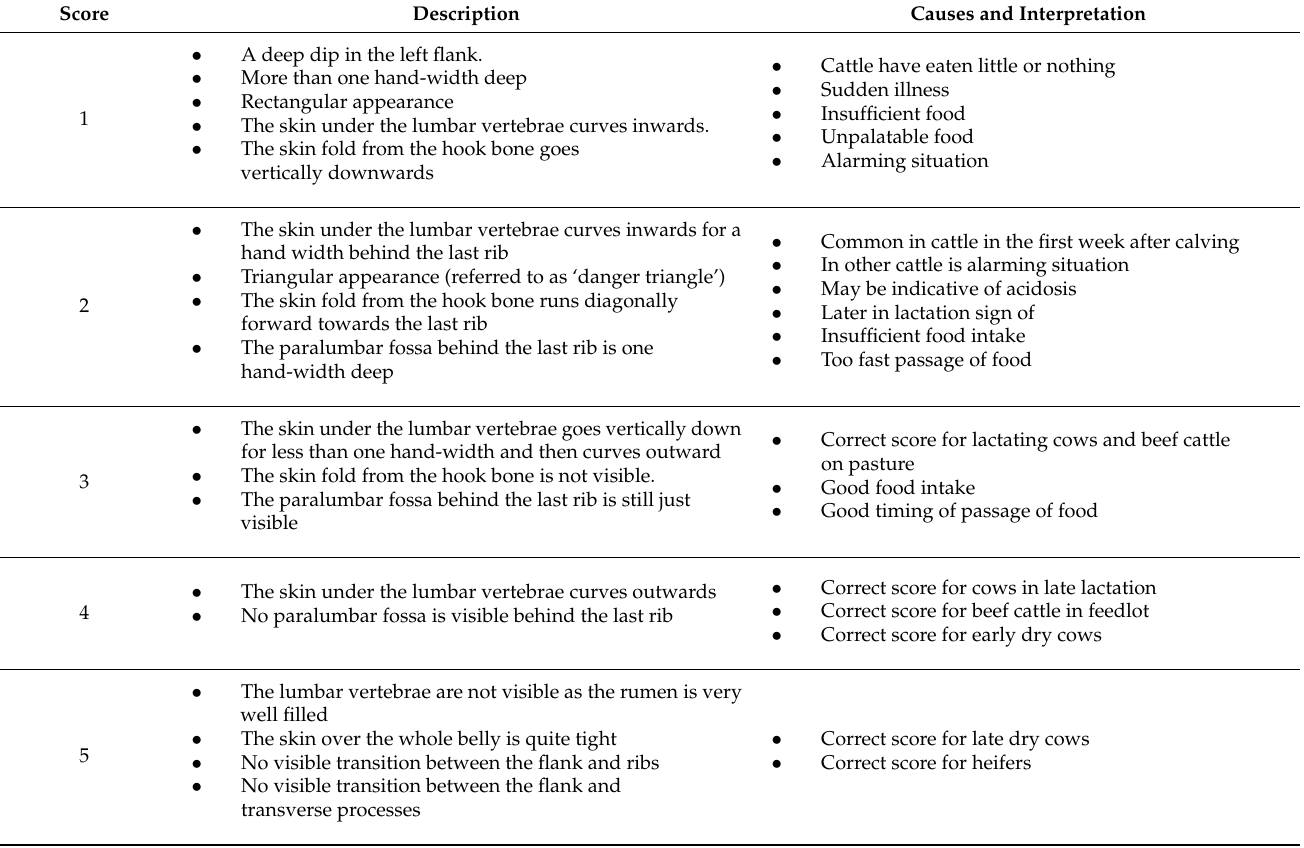
Table 8. Description of the scoring system of rumen fill, with causes and interpretations of the